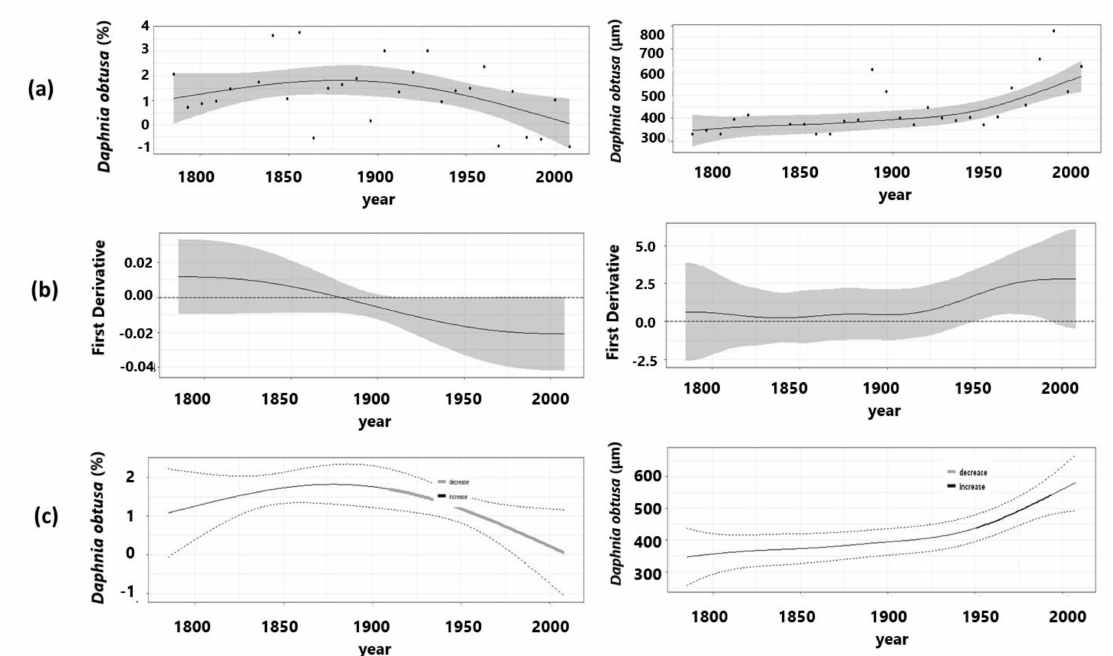
Figure 5. GAM fitted to the time series of Daphnia obtuse ephippia abundance (left pannel) and ephippia size (right pannel) in the sedimentary archive of Lake Blanca Chica. ( a ) Observed values, GAM-based trend fitted and its simultaneous interval; ( b ) estimated first derivative of the GAM fitted trend and the 95% simultaneous interval; ( c ) period of transition.